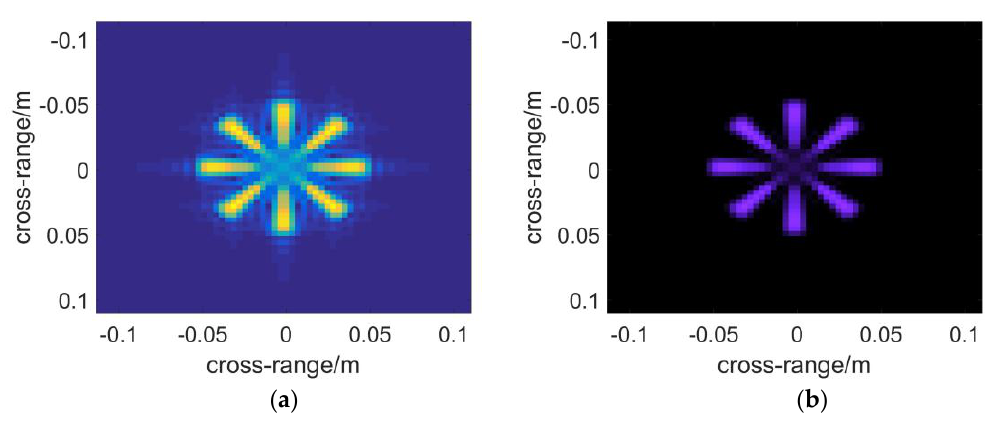
( b ) Figure 11. The setup of the experiment: ( a ) the experiment platform; ( b ) the sample to be imaged.